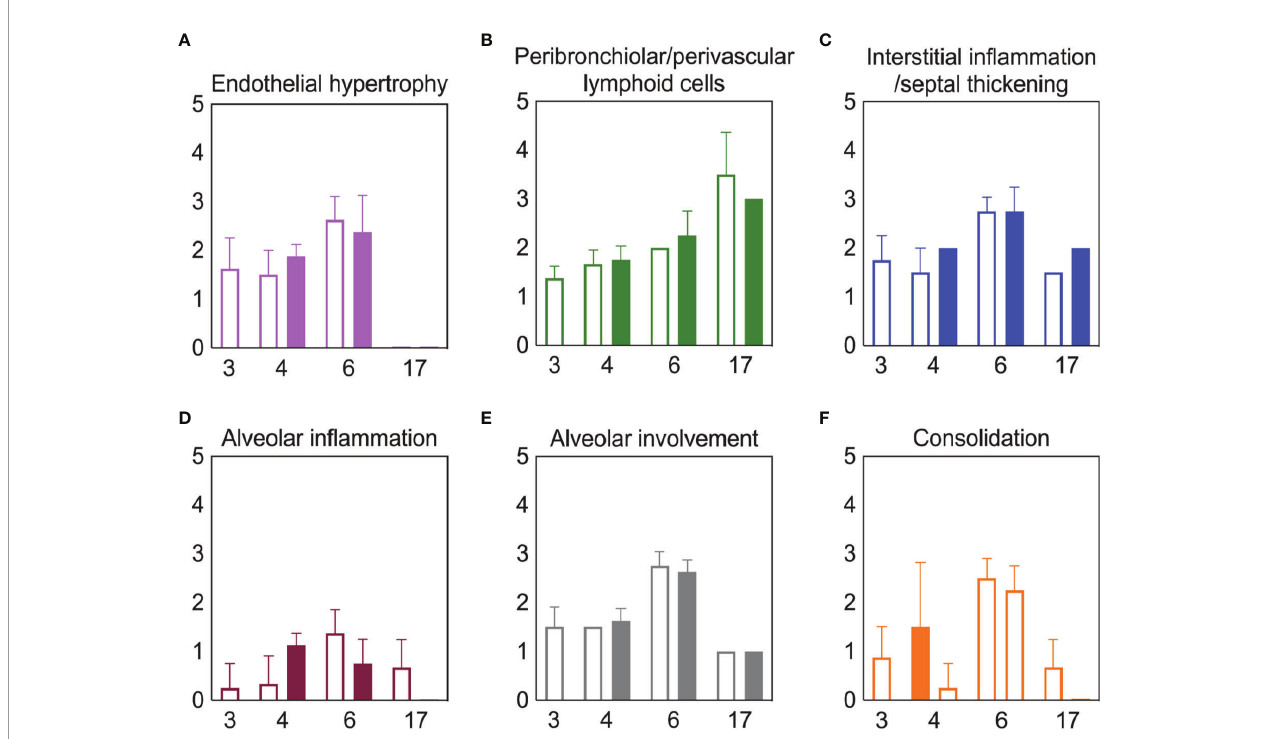
FIGURE 5 | Lung pathology during SARS-CoV-2 infection and pneumococcal coinfection. Average endothelial hypertrophy (A) , peribronchiolar/perivascular lymphoid cells (B) , interstitial in fl ammation/septal thickening (C) , alveolar in fl ammation (D) , extent of alveolar involvement (E) , and consolidation (F) in lungs of mice infected with SARS-CoV-2 (250 PFU; open bars) followed by 10 3 CFU D39 at 3 or 5 d pvi ( fi lled bars). Plots represent the mean ± standard deviation (SD) bars for combined male and female